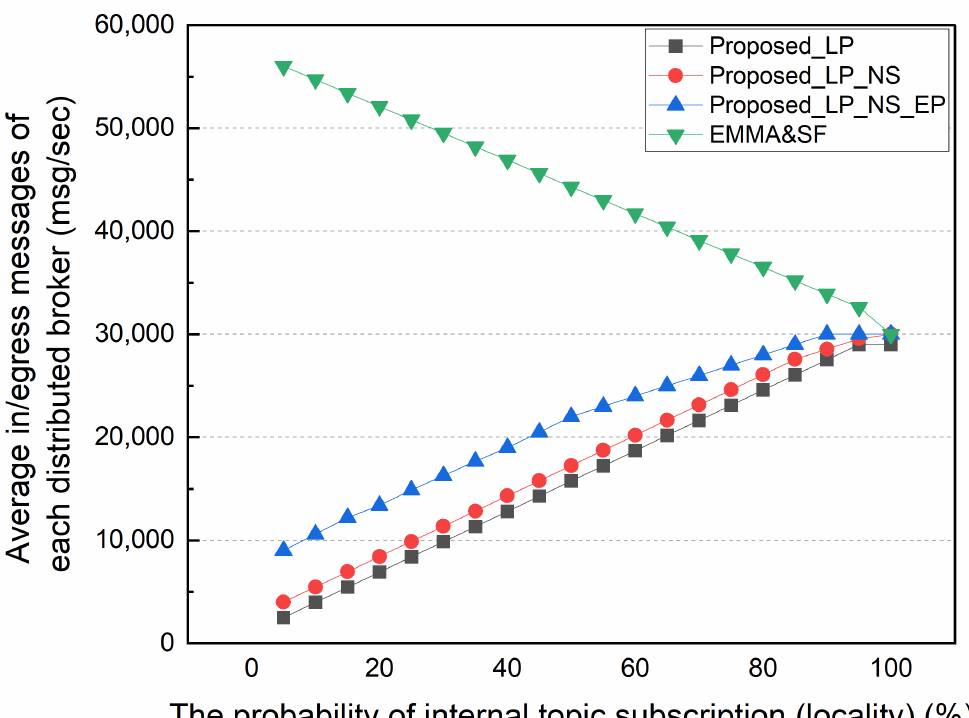
Figure 9. Average number of in/egress messages by subscription